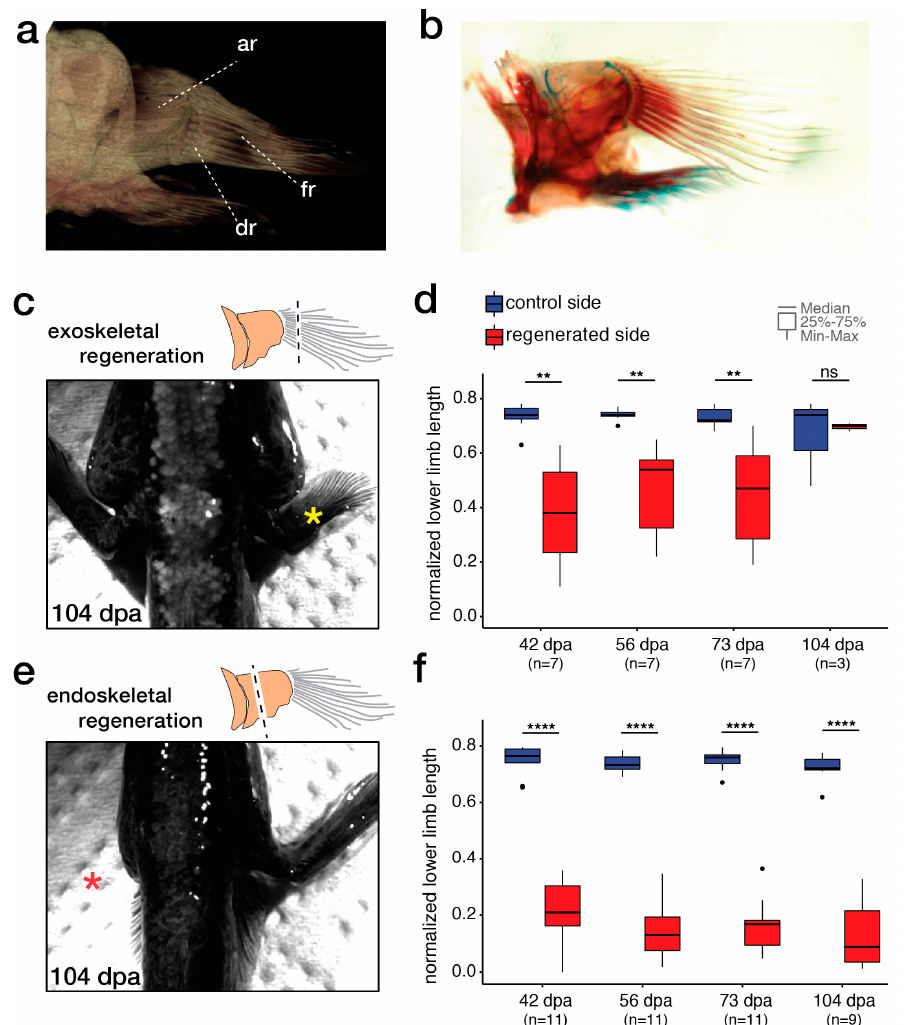
Figure 3. Differing exo- and endoskeletal regenerative capacities in mudskippers. ( a , b ) Mudskippers have well-developed endoskeletons with four large proximal radials (ar—anterior radials; dr—distal radials; fr—fin rays). ( c ) 104 days after exoskeletal amputation, a completely regenerated fin can be observed (The yellow asterisk denotes the regenerated fin). ( d ) The dynamics of the regenerative process shows gradual regeneration. ( e ) After endoskeletal amputation, no regeneration was observed (Red asterisk denotes the side of the amputated fin). ( f ) During the observation period, the size of the amputated stump did not change (**: p < 0.01; ****: p < 0.0001; ns: not significant). Exoskeletal regeneration was complete by the end of the observation period, the fins in all the observed animals recovering their original length (Figure 3c,d). In stark contrast, endoskeletal